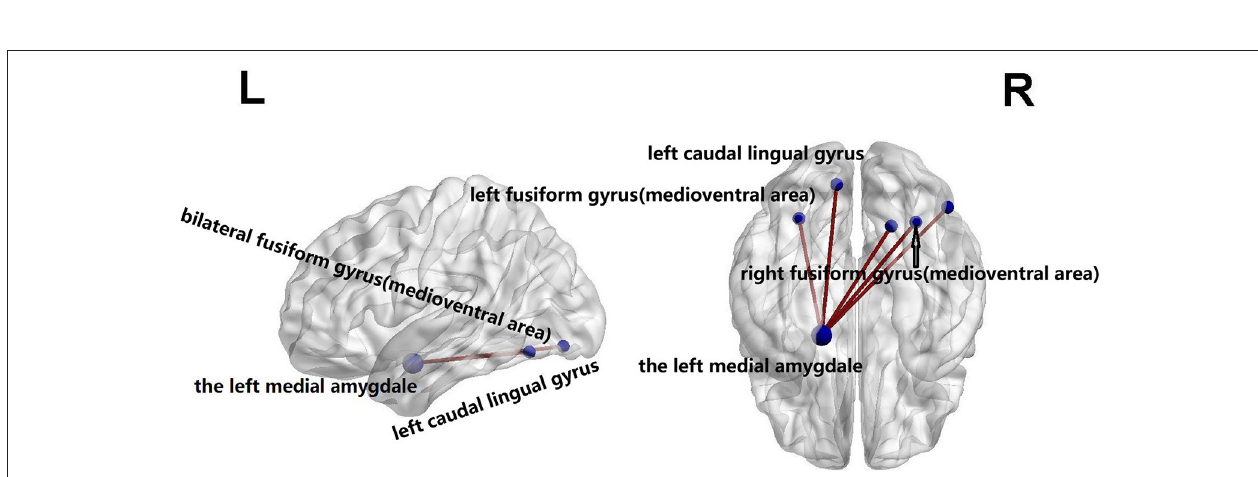
FIGURE 2 | Brain regions showing the decreased nodal degree in familial PD group compared with sporadic PD group ( p = 3 × 10 − 5 ) on the fourth wavelet scale.